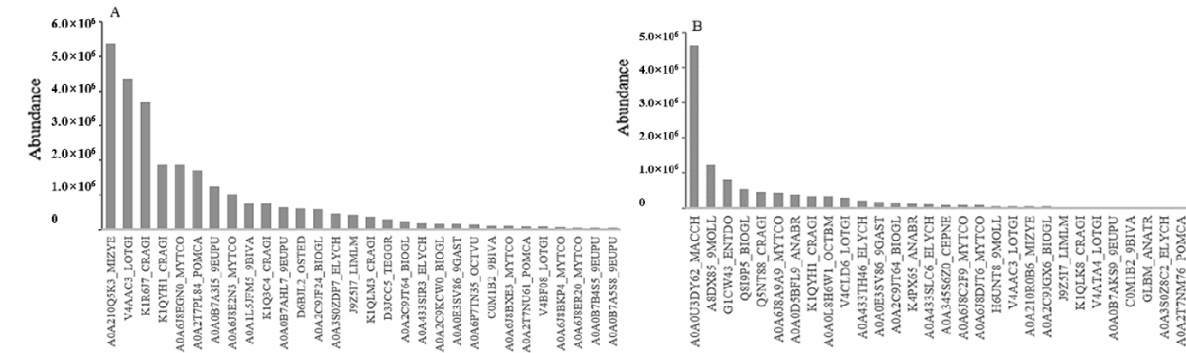
Figure 5. Top 30 most abundant prey proteins for bait ORF25 by MS/MS analysis. Subfigures ( A , B ) correspond to the results for the proteins identified in bands e and f.